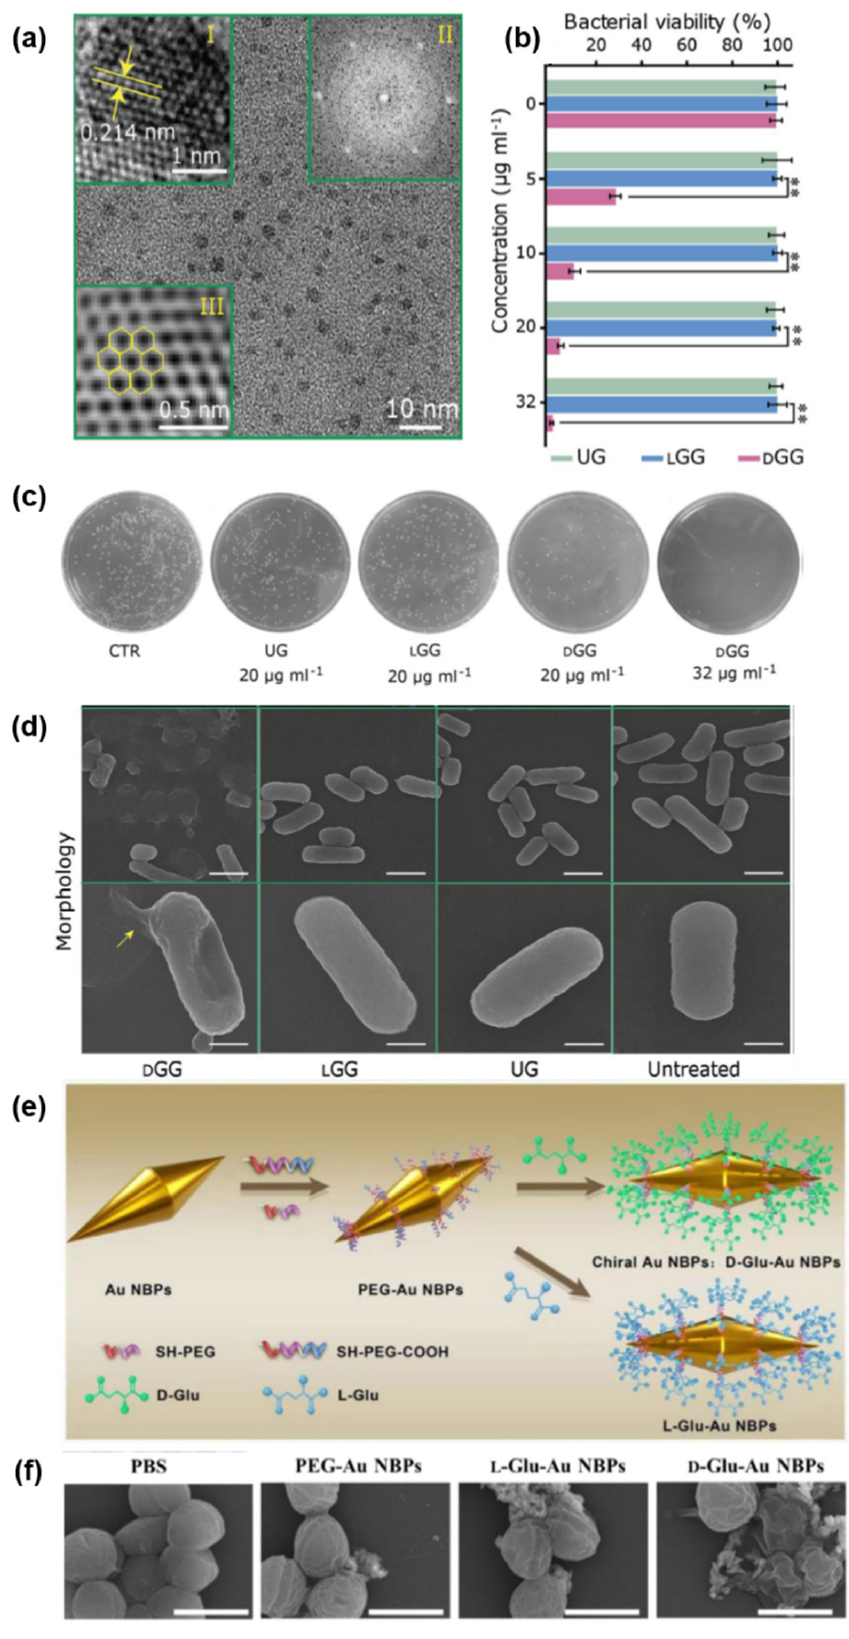
Figure 5. ( a ) TEM images of D- GGs. Inset I, II and III are the high-resolution TEM, corresponding fast Fourier transform (FFT) and reverse FFT images of D- GGs, respectively. Yellow arrows in inset I indicate the (100) lattice fringe of chiral graphene QDs and yellow hexagons in inset III indicate hexagonal crystalline structure of the QDs. ( b ) Antimicrobial activities of chiral GQDs and UGs against S. aureus evaluated by a standard plate count method , ** p < 0.01. ( c ) Antimicrobial activities of chiral GQDs and UGs against E. coli . ( d ) SEM images of E. coli after incubating D- GGs, L- GGs, UGs and normal saline as the control for 3 h, respectively, scale bar = 1 μ m (first low), 500 nm (sec- ond row, yellow arrow indicates the leaked cellular content). ( e ) Schematic illustration of D- / L- Glu- Au NBP fabrication. ( f ) SEM images of S. epidermidis treated by phosphate-buffered saline (PBS), PEG-Au NBPs and L- / D- Glu-Au NBPs for 3 h, scale bar = 1 μ m. Reprinted with permission from Refs. [21,27] . Copyright 2016 John Wiley and Sons. Copyright 2020 Elsevier.